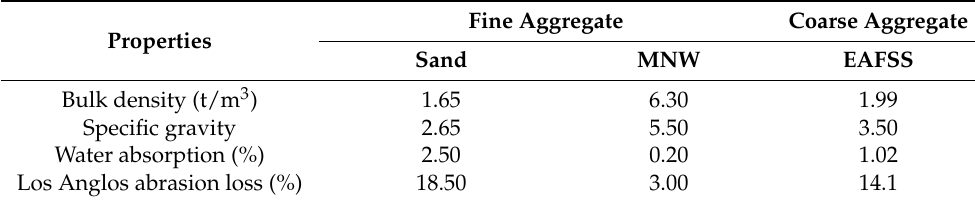
Table 1. Physical properties of fine and coarse